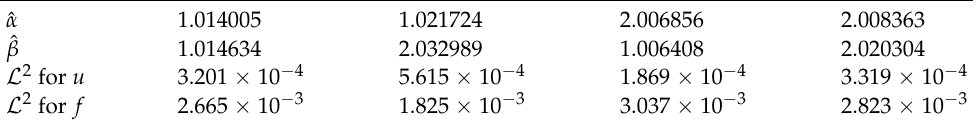
Table 1. High-order partial differential equation: estimated values of ( α , β ) and the relative error L 2 for u ( t , x ) and f ( t , x ) , where N u = 50, N f = 40, and ( α , β ) is fixed to be (1, 1), (1, 2), (2, 1) and (2, 2) in